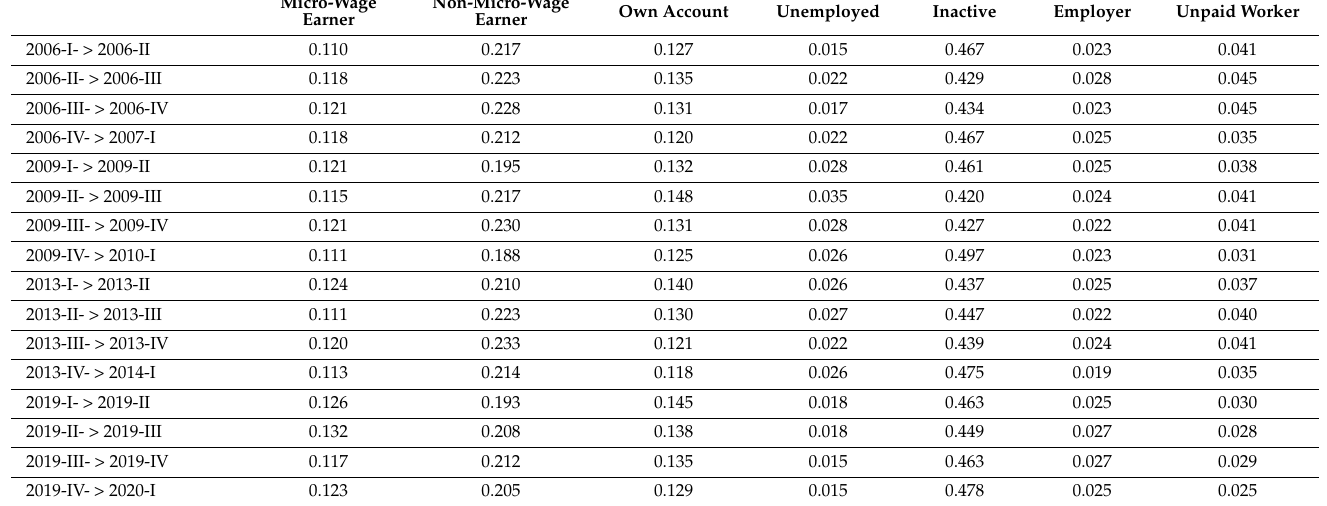
Table 4. Employment-transition steady states in Mexico.